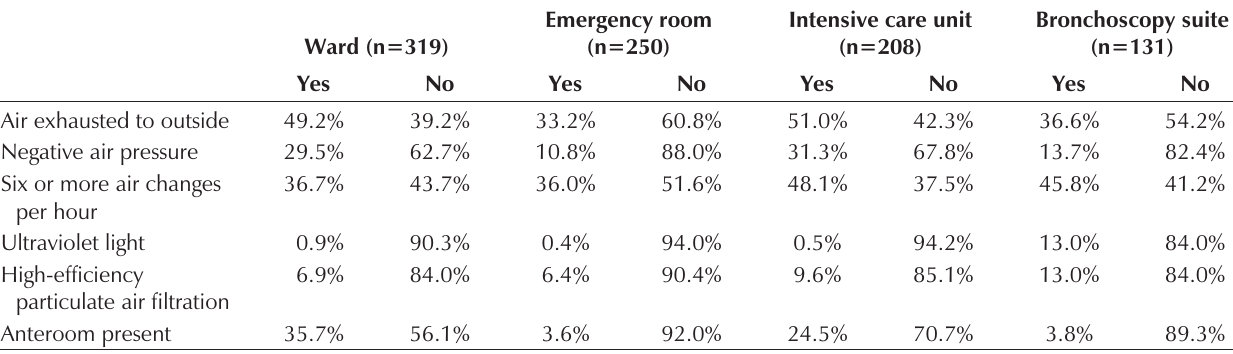
Engineering and environmental measures present in acute care hospitals